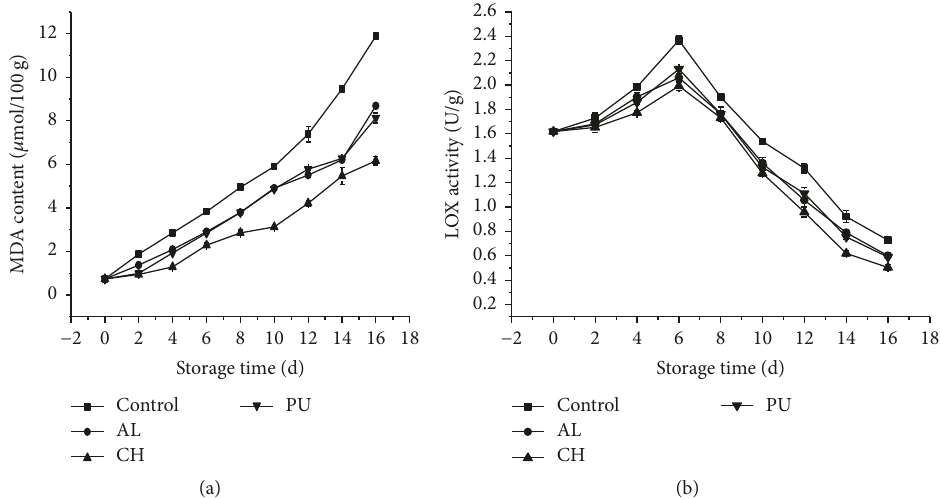
Figure 4: Effects of three different polysaccharide-based edible coatings on MDA content (a) and LOX activity (b) of strawberry.